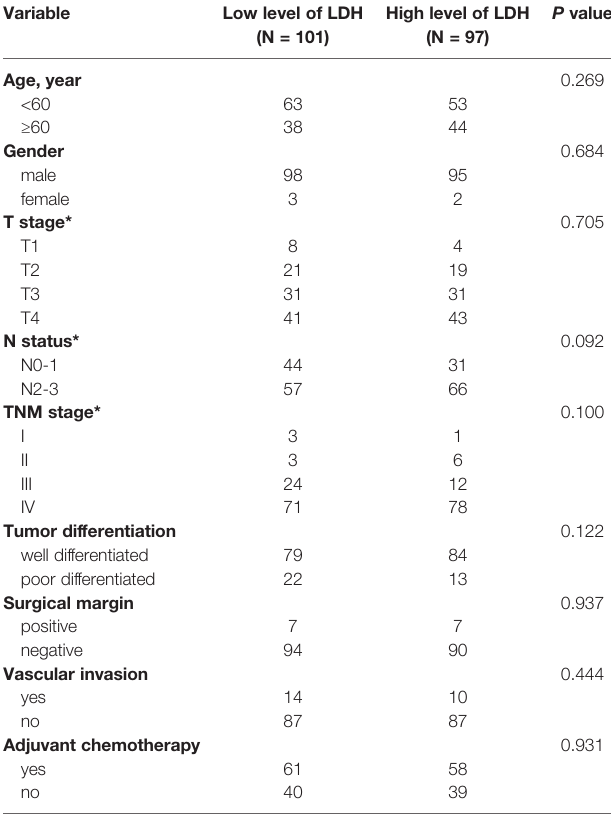
TABLE 1 | Baseline characteristics of patients with pretreatment serum LDH ≤ and >178 U/L.